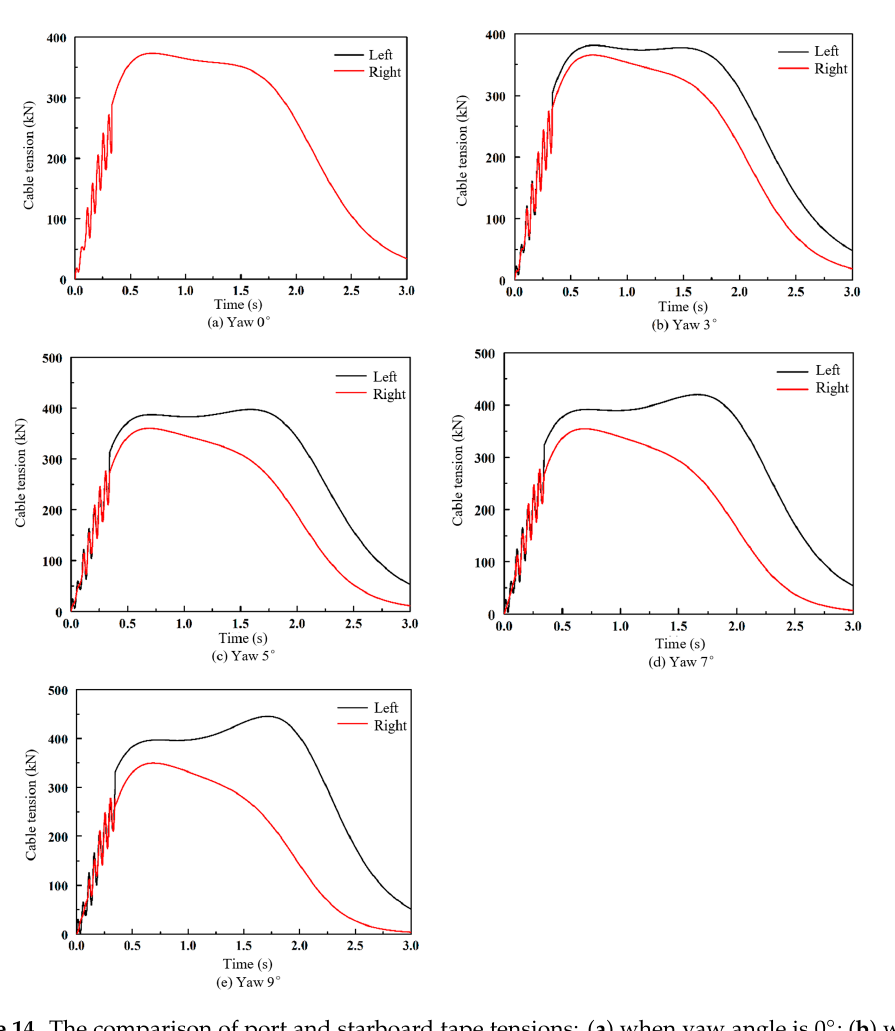
Figure 14. The comparison of port and starboard tape tensions: ( a ) when yaw angle is 0°; ( b ) when yaw angle is 3°; ( c ) when yaw angle is 5°; ( d ) when yaw angle is 7°; ( e ) when yaw angle is 9°.